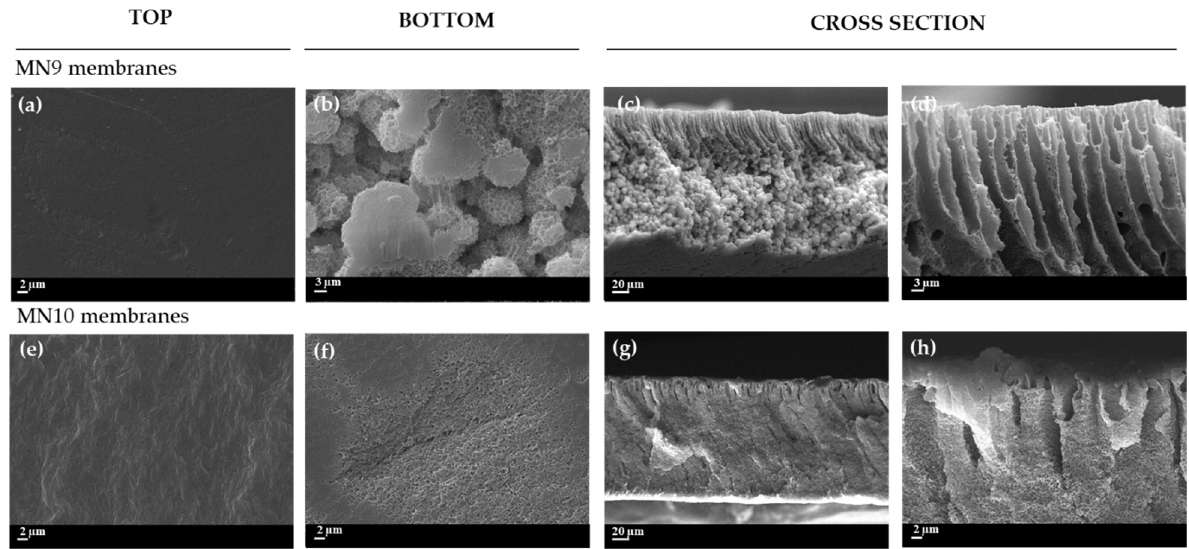
Figure 4. SEM image of prepared PVDF (18 wt%) membranes: ( a – d ) surface (top and bottom Mag. 5.00 KX) and cross-section (Mag. 800 X and 5.00 KX) of MN9 with PEG 200 (20 wt%) and ( e – h ) surface (top and bottom Mag. 5.00 KX) and cross-section (Mag. 800 X and 5.00 KX) of MN10 with PEG 200 (20 wt%) and PVP K17 (5 wt%).